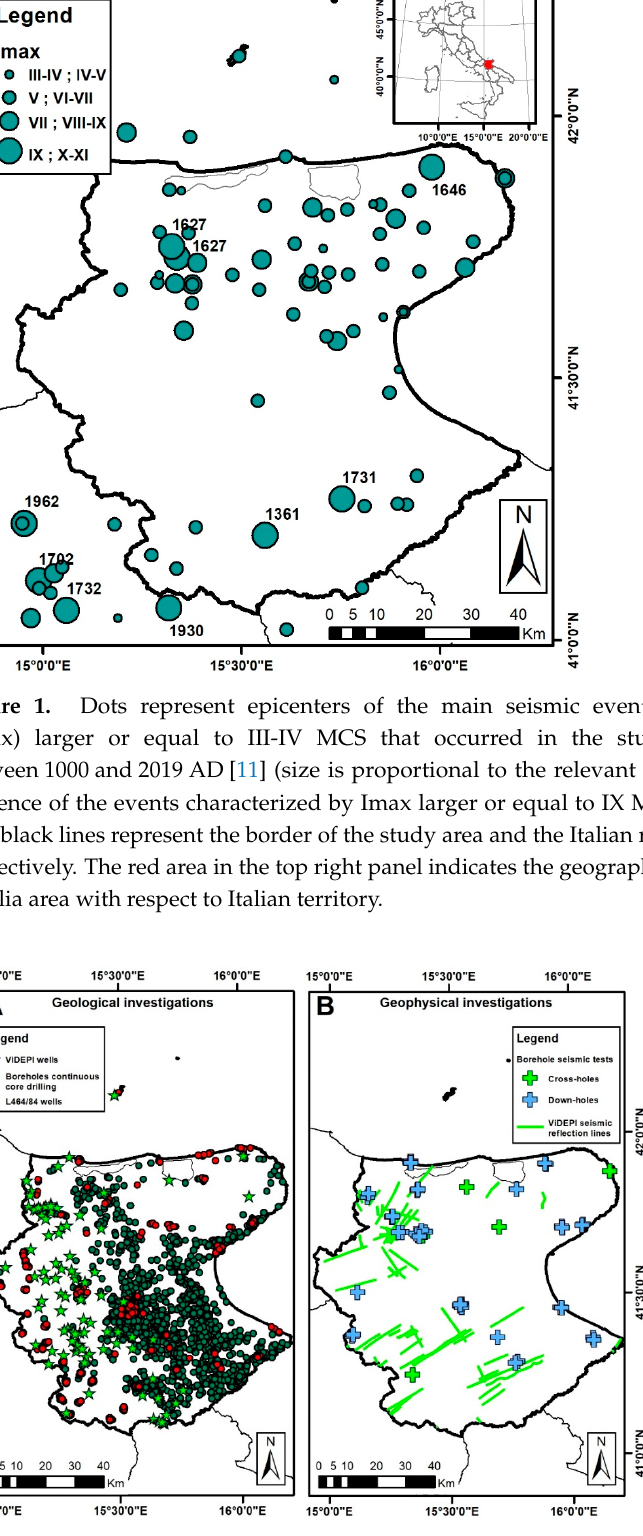
Figure 2. Location of the geological ( A ) and geophysical ( B ) investigations available in the study area. The thick and thin black lines represent the border of the study area and the Italian regional administrative limits, respectively.